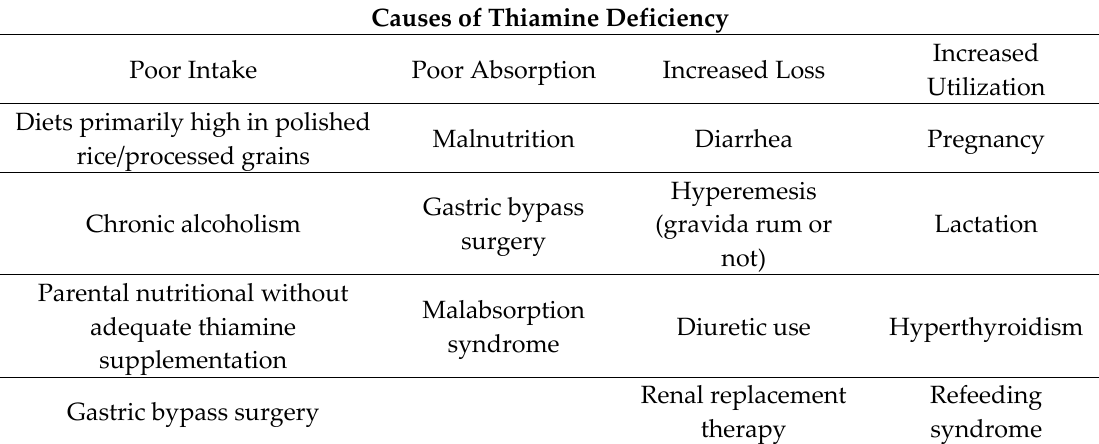
Table 2. Causes of thiamine deficiency